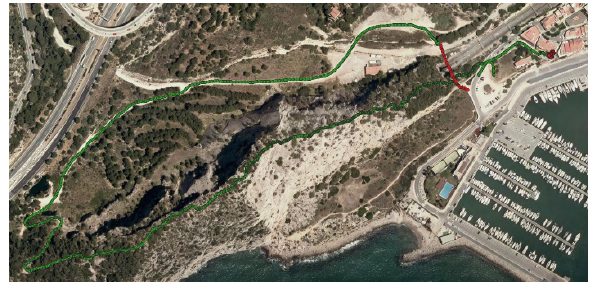
Figure 7 . Estimated “Sa Falconera” trajectory. Green dots indicate positions provided by the GNSS while red dots are the ones provided by camera-based tracking system.